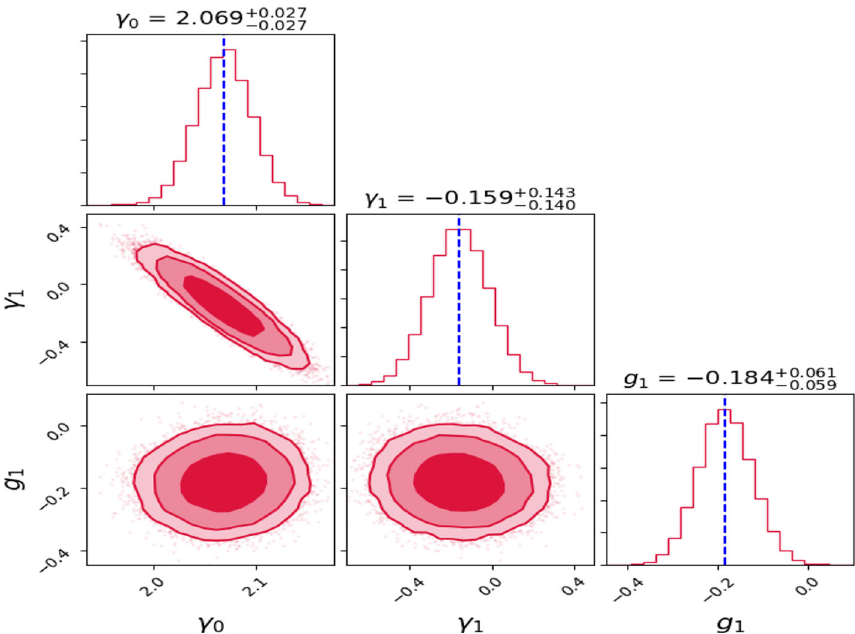
Fig. 8 Constraints on γ 0 , γ 1 , and g 1 parameters for the Intermediate mass range SGL sample. Here, γ 1 encodes the redshift evolution of γ . We find only a marginal 1.1 σ decrease with redshift for